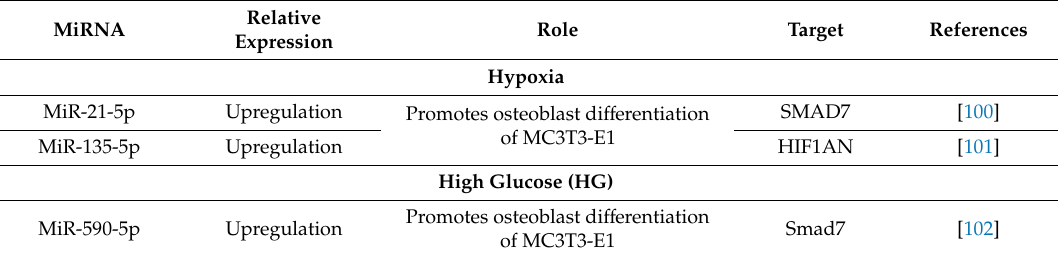
Table 6. MiRNAs involved in osteoblast regulation under di ff erent